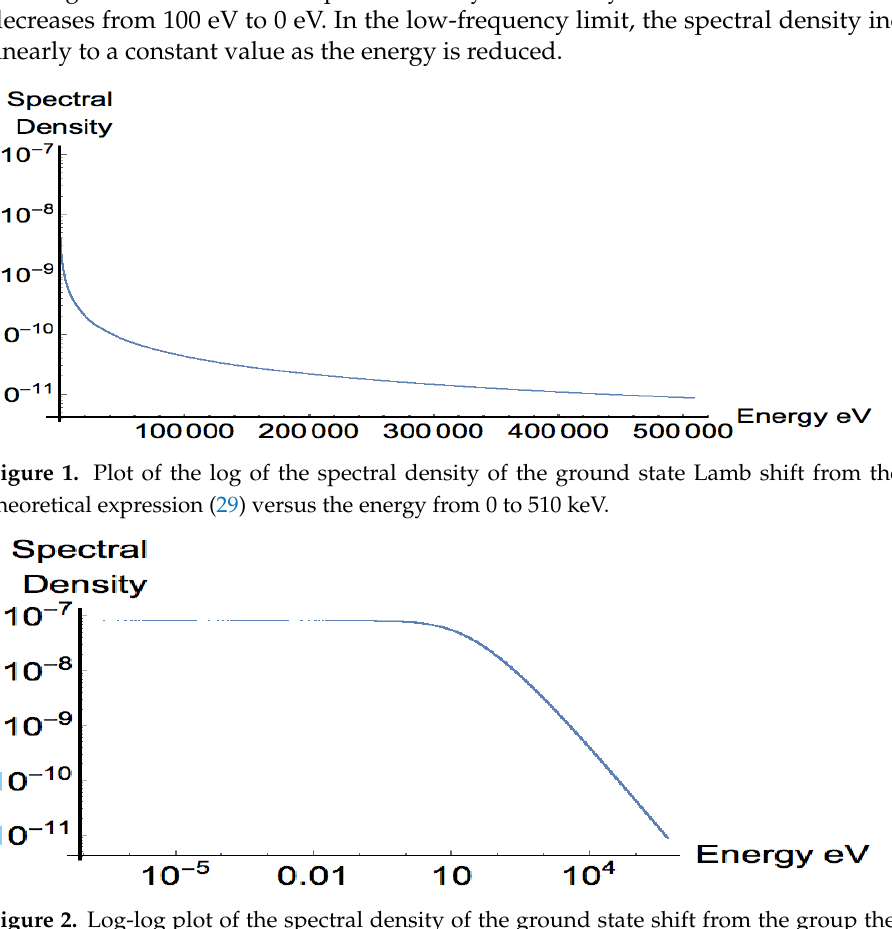
Figure 2. Log-log plot of the spectral density of the ground state shift from the group theoretical expression (29) versus the energy. For energies above about 1000 eV, the behavior is dominated by a 1/energy dependence. From about 10 eV to 0 eV, there is a slow linear increase in the spectral